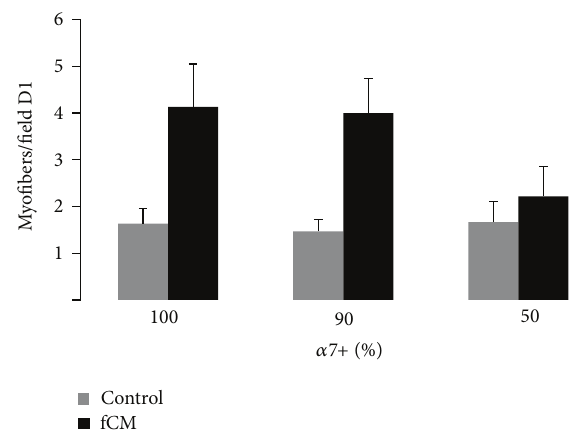
Figure 5: Myofiber density in 𝛼 7+/ 𝛼 7 − tissue sheets with varied initial cell concentration; 100% 𝛼 7+ with 0% 𝛼 7 − , 90% 𝛼 7+ with 10% 𝛼 7 − , to from 50% 𝛼 7+ with 50% 𝛼 7 − . Bars show 𝑛 = 3 tissue sheets per group. “ ∗ ” statistically significant between the indicated pairings, 𝑃 < 0.05